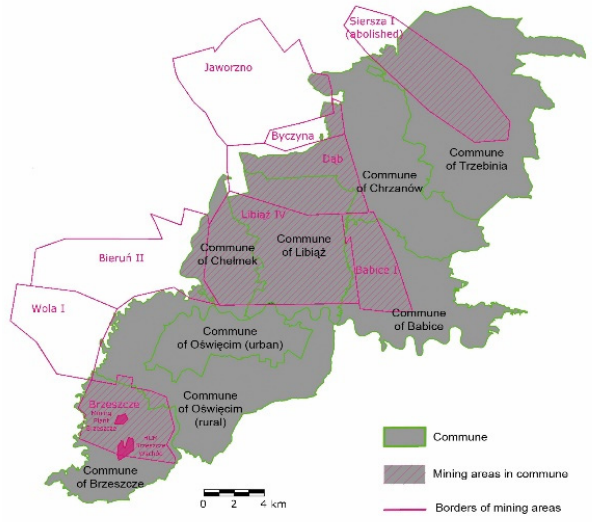
Figure 5. Location of mining areas within the Małopolska communes (source: own study based on [22]).